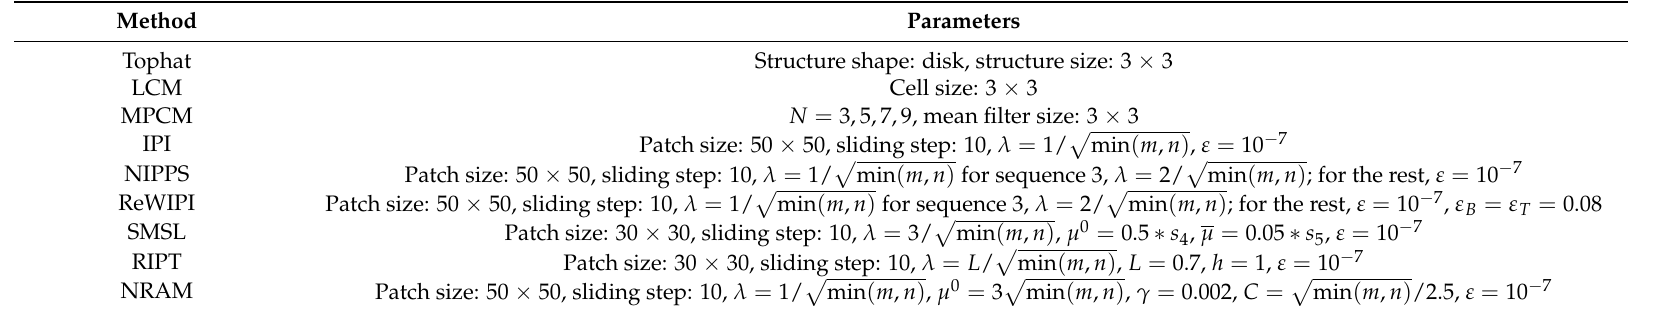
Table 3. Detailed parameter settings of the nine tested